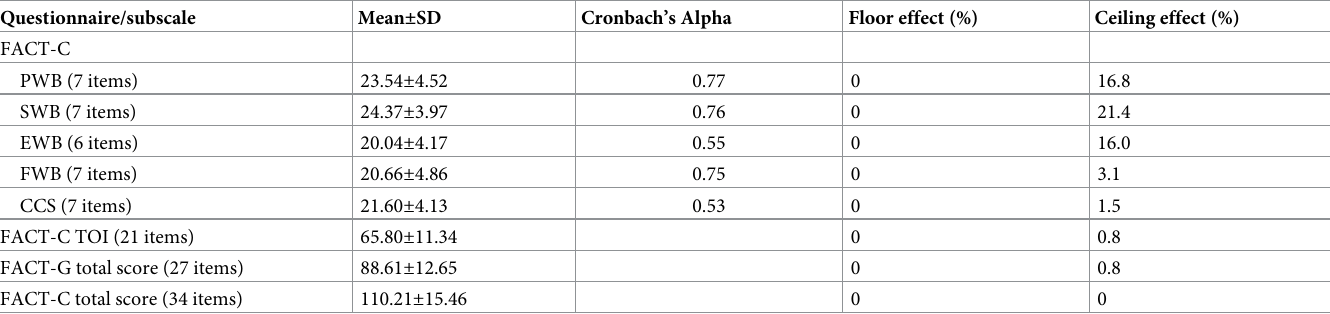
Table 2. Descriptive statistics, ceiling and floor effects of health-related quality of life questionnaire